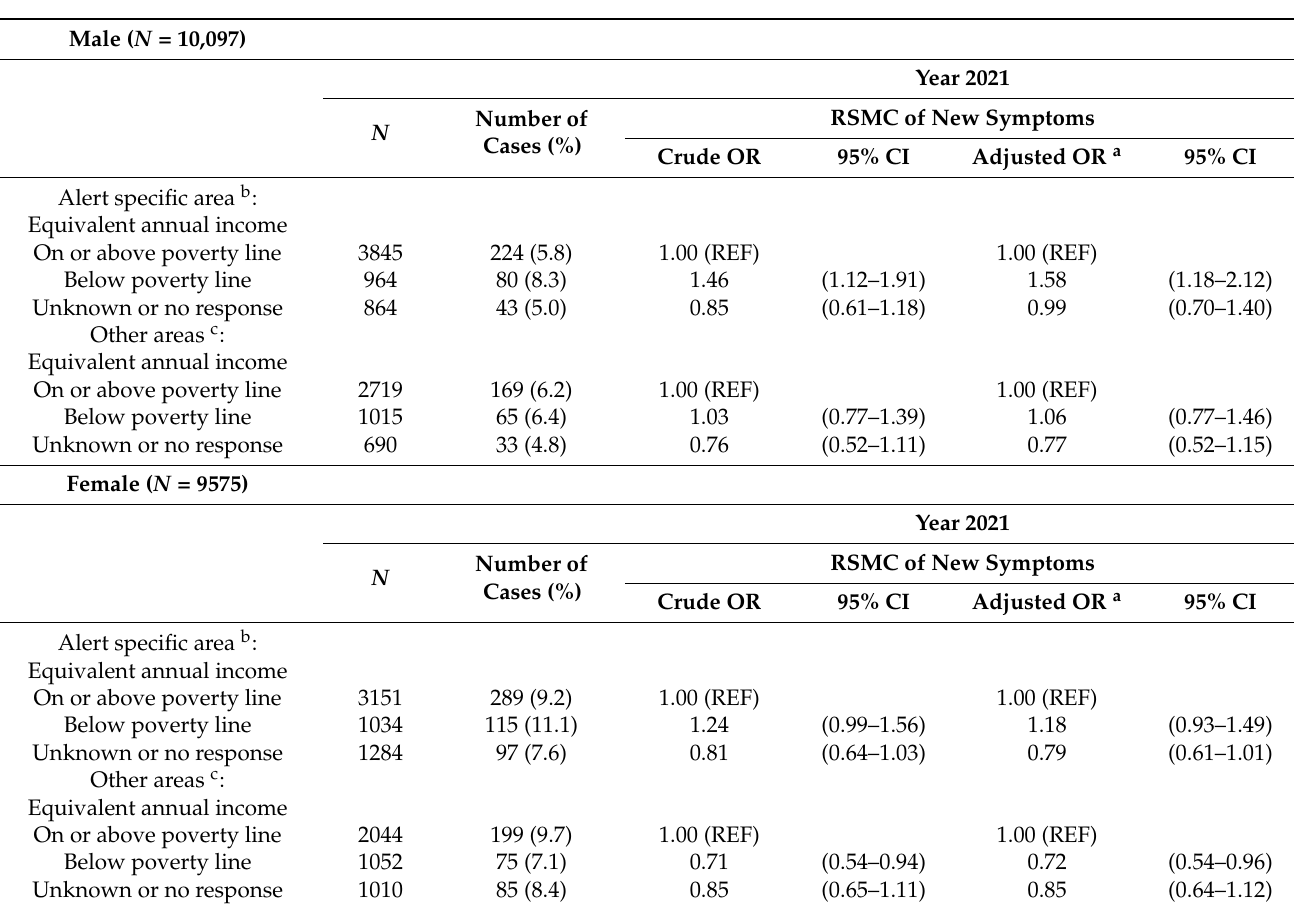
Table 5. Odds ratios (ORs) of household income for refraining from seeking medical care (RSMC) of new symptoms according to specific alert